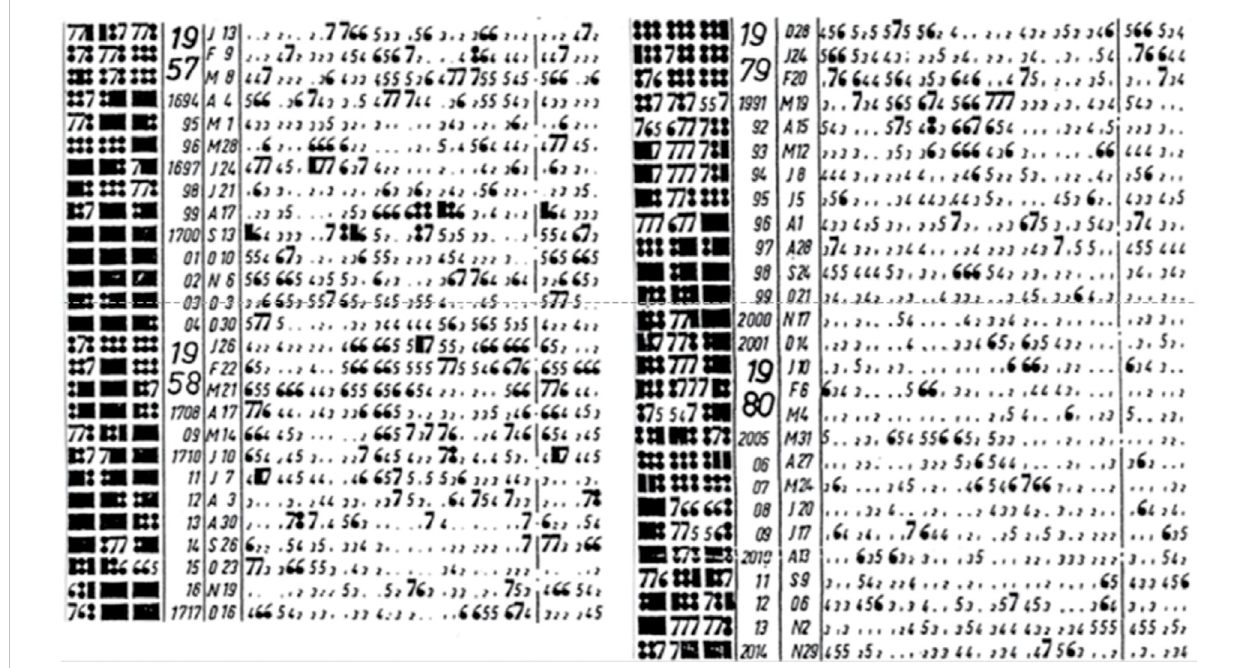
FIGURE 11 The C9 index during very active periods of the sun. The format is the same as that of this Figure. Left: In the middle period, two recurrent geomagnetic storms occurred, indicating that the quasi-sinusoidal curve was present. Right: There were hardly any intense geomagnetic storms during the later part of 1979 and 1980, suggesting also a low speed fl